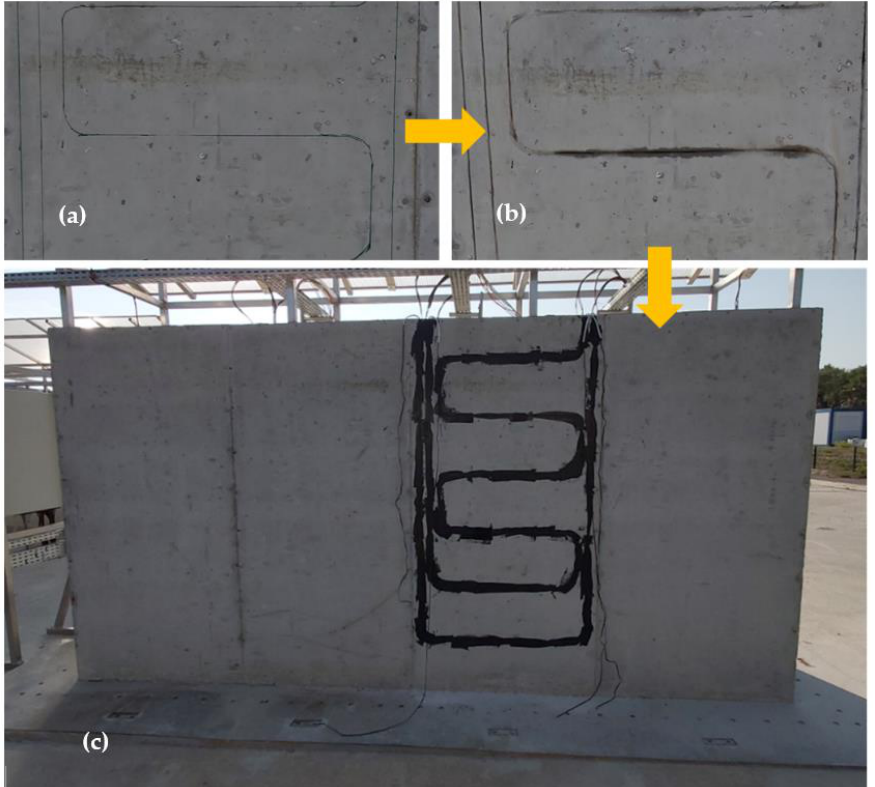
Figure 13. Installation steps of the DOFS cable at the surface of block KB. ( a ) Marking of the cable path at the surface of concrete ( b ) engraving of the groove along the path ( c ) insertion of the DOFS cable into the groove and application of the closing layer of X120 adhesive.